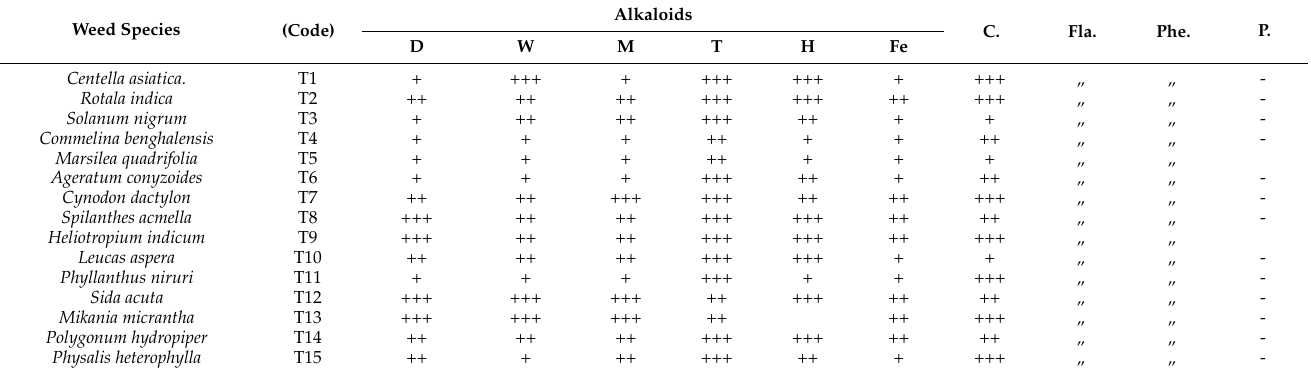
Table 6. Qualitative test for phytochemical screening of root exudates of fifteen weed species. Weed Species Centella